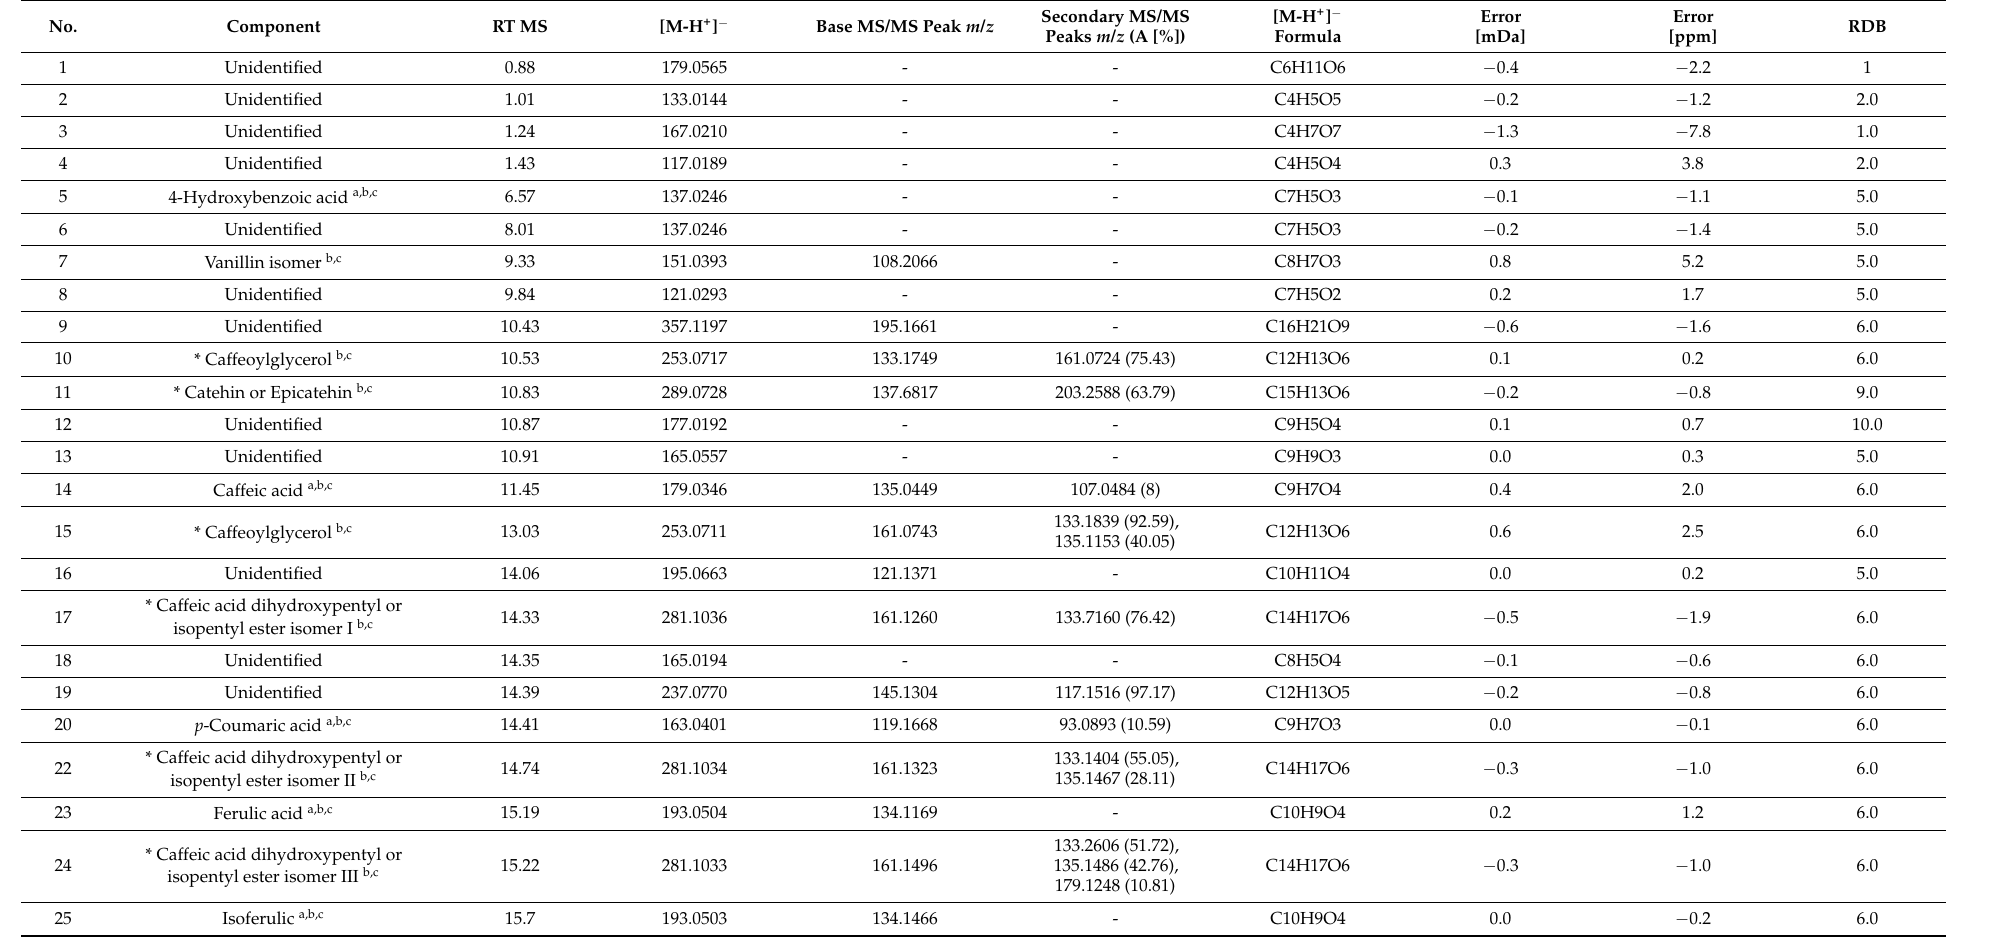
Table 1. Identification of propolis components in 70EEP by uHPLC-MS/MS